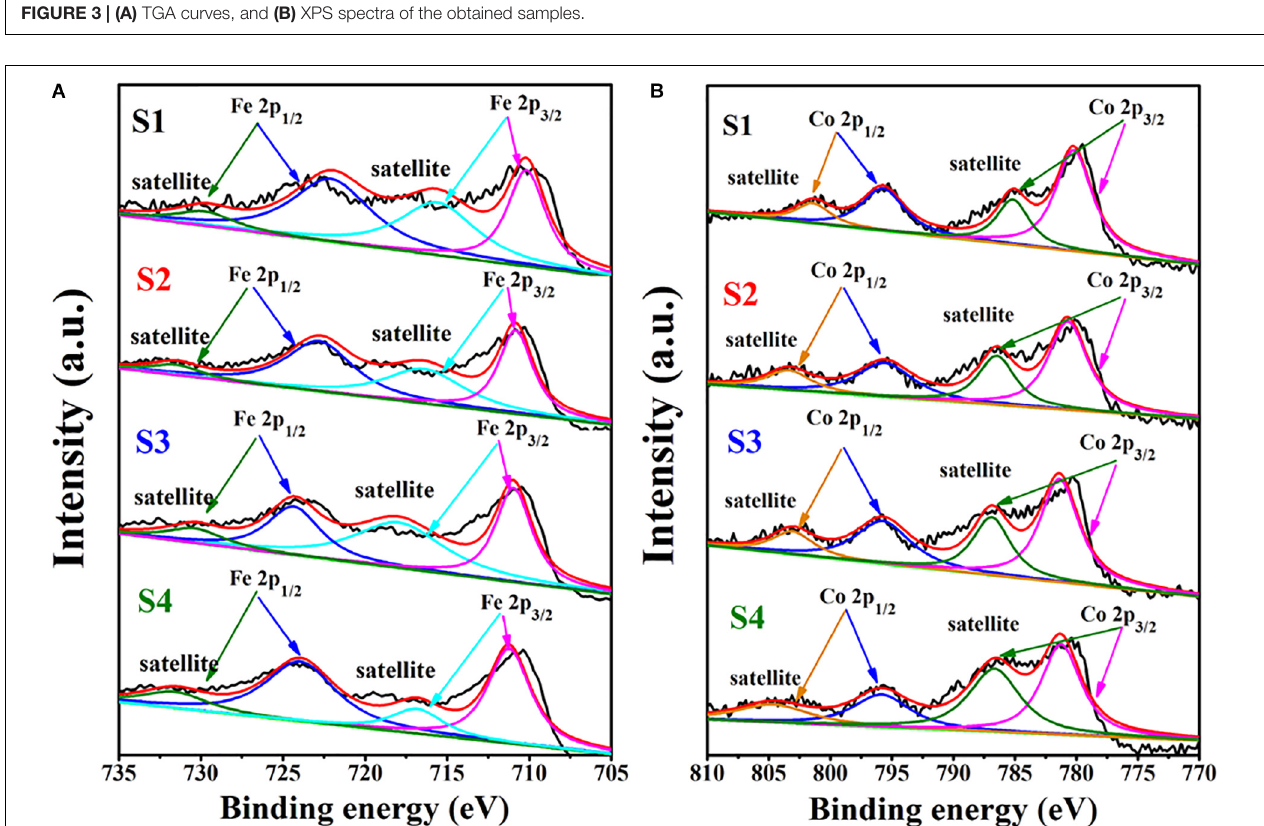
FIGURE 4 | High resolution XPS spectra of (A) Fe 2p, and (B) Co 2p peaks for the as-prepared samples.